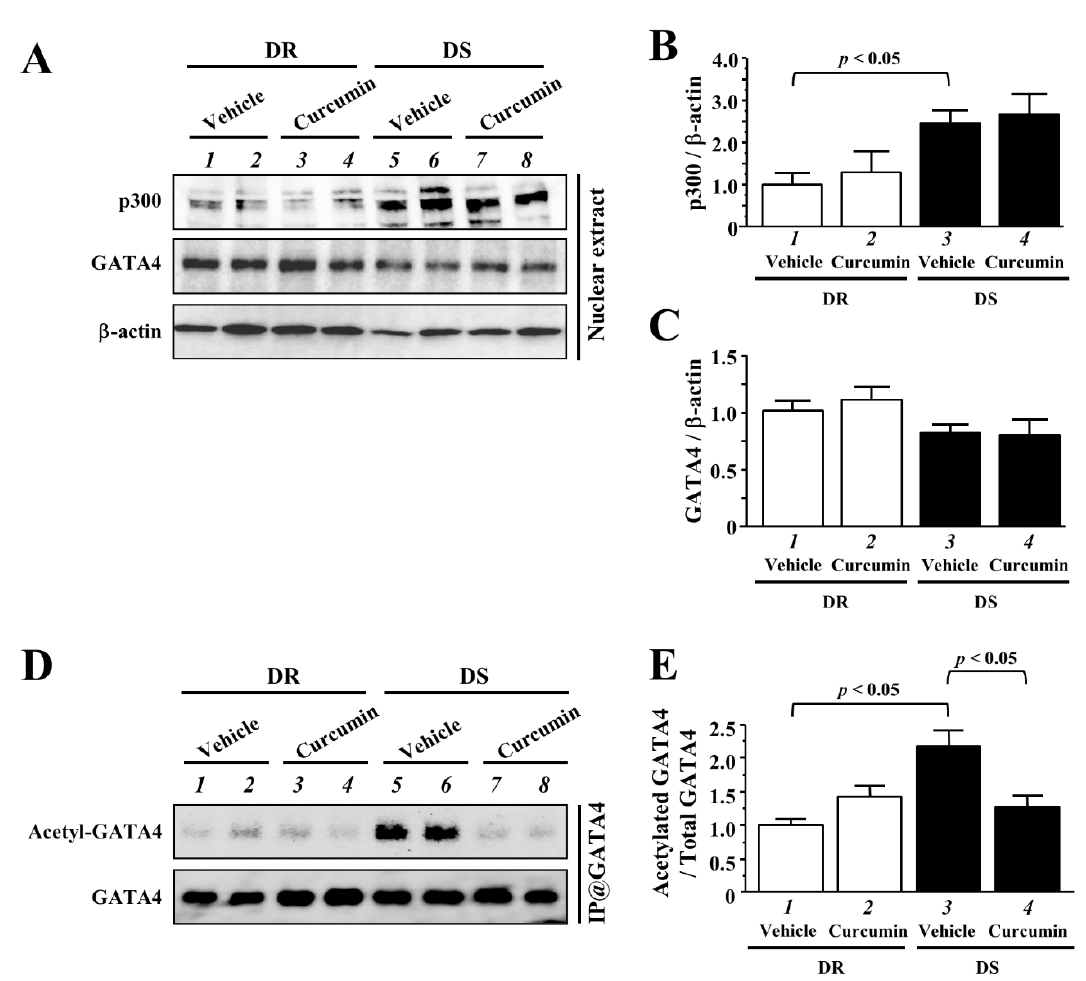
Figure 5. Curcumin significantly prevented hemodynamic overload-induced acetylation of GATA4 in DS rats. ( A ) Nuclear extracts (NE) of LV tissues in each rat were subjected to western blotting with indicated antibodies. ( B , C ) The protein levels of p300 ( B ) and GATA4 ( C ) were normalized by β -actin. ( D ) The immunoprecipitated samples with anti-GATA4 antibody were subjected to western blotting with indicated antibodies. ( E ) The acetylated level of GATA4 was normalized to total GATA4. The band intensities were quantified using Image J v1.47 software. The values are represented as the mean ± SEM. All values were normalized to DR vehicle group, which was set at 1.0 as the control.